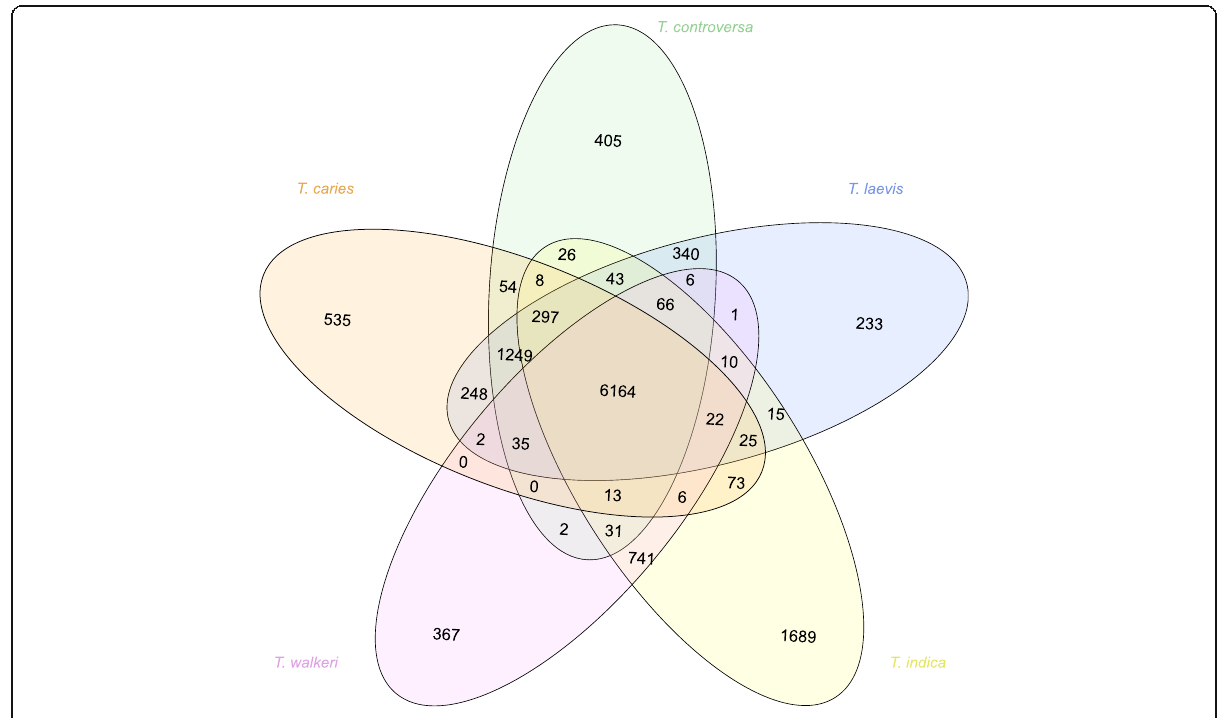
Fig. 2 Unique and shared orthogroups between the five Tilletia species from OrthoFinder ’ s